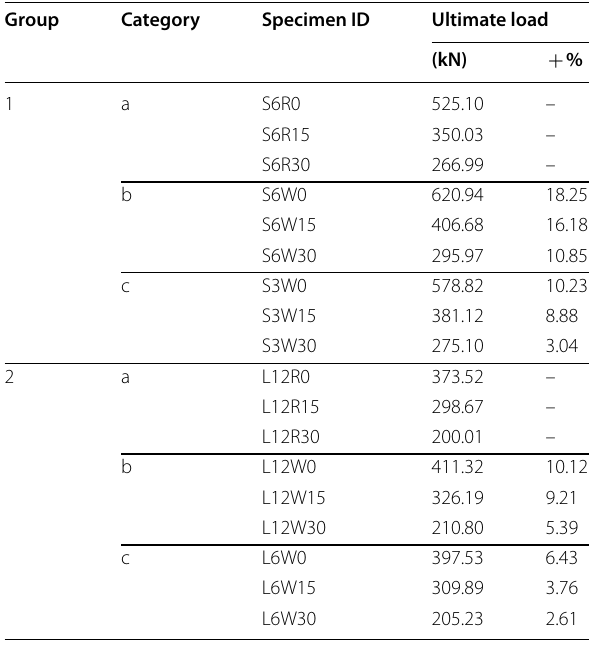
Table 6 Results of tested column specimens